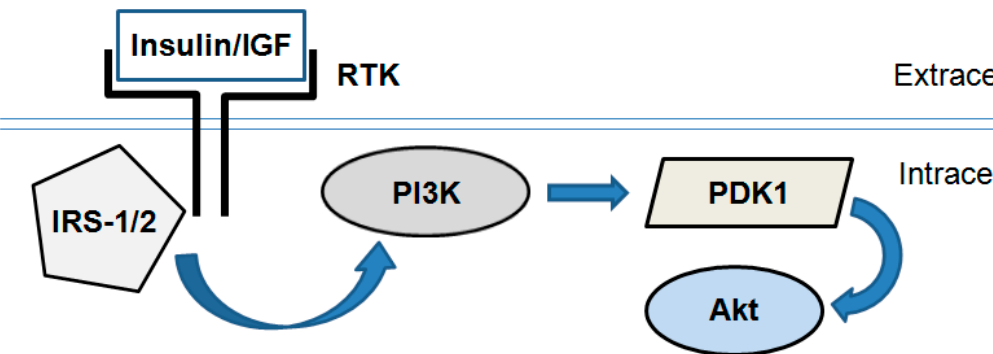
Figure 2. Simplified scheme of the PI3K/Akt signaling pathway. Insulin or insulin-like growth factor-1 (IGF) binds and activates receptor tyrosine kinases (RTK; i.e., insulin receptor). In turn they activate an intracellular signal transduction cascade consisting of several enzymes: Insulin receptor substrate-1/2 (IRS-1/2), phosphoinositide-3-kinase (PI3K), phosphoinositide-dependent kinase 1 (PDK1) and Akt/PKB.